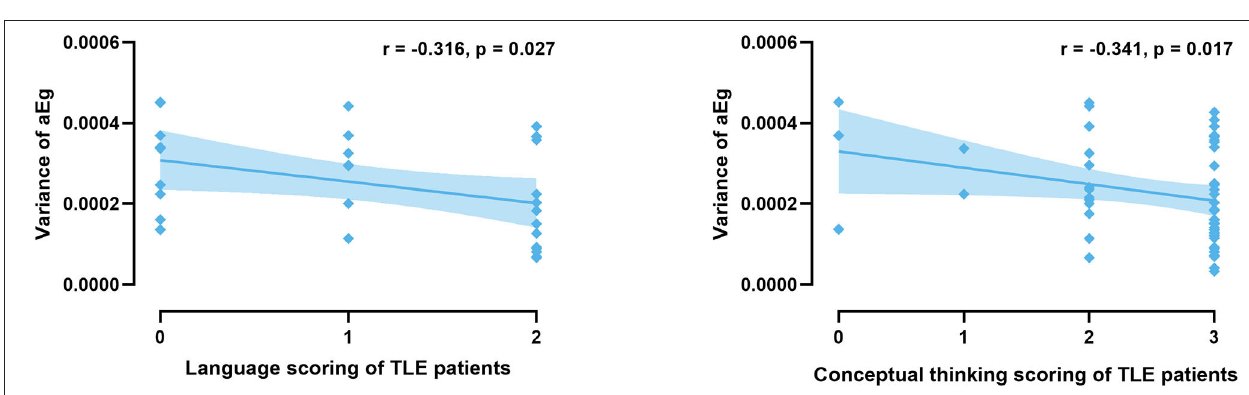
FIGURE 8 | Significant correlations are present between characteristics and cognitive performance in all TLE